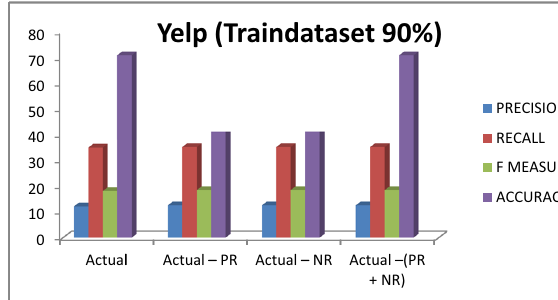
Figure 3: Plot for Yelp 90% train dataset.